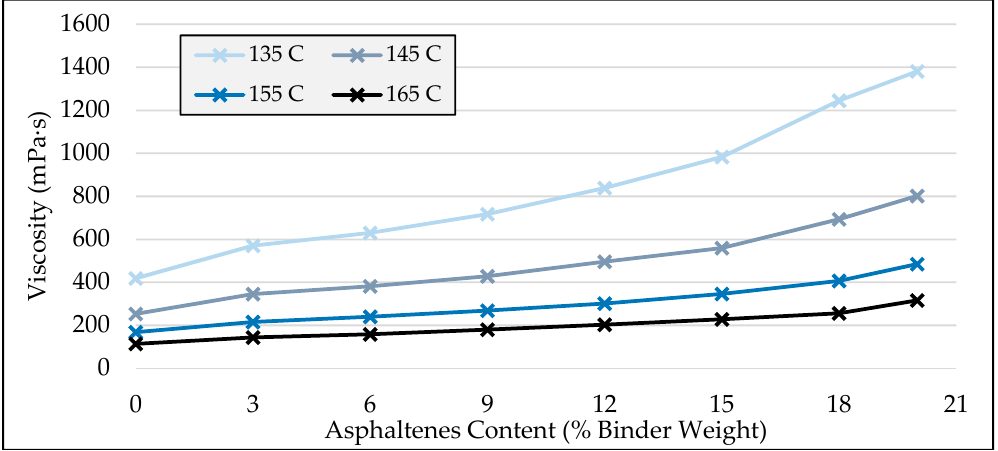
Figure 6. High-temperature viscosity of asphaltenes-modified binders versus asphaltenes content.